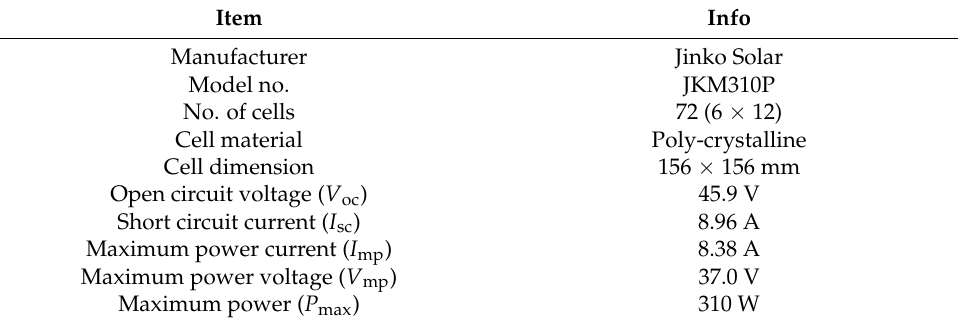
Table 1. Specification of the PV